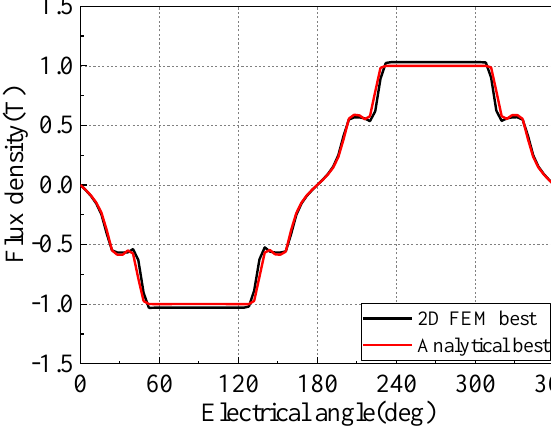
Figure 12. Comparison of air gap flux density waveforms.